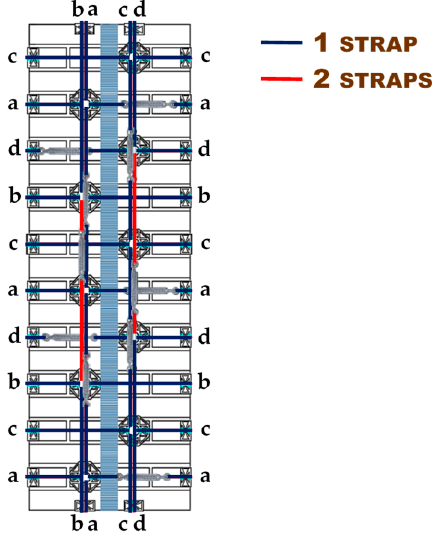
Figure 41. Preparation of the specimen: ( a ) restoration of the 10th mortar bed joint from below (front view) and ( b ) application of the CFRP strips after the maturing period (back view).